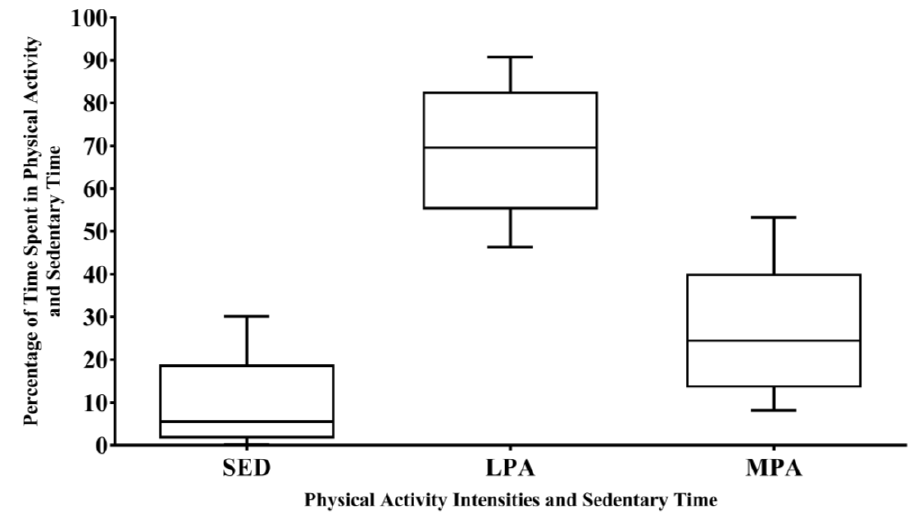
Figure 1. Proportion of time spent in physical activity and sedentary time during a planned burn operation. Data are displayed as median and 1st and 3rd quartile with the range between minimum and maximum values. SED = sedentary time; LPA = light-intensity physical activity; MPA = moderate-intensity physical activity.